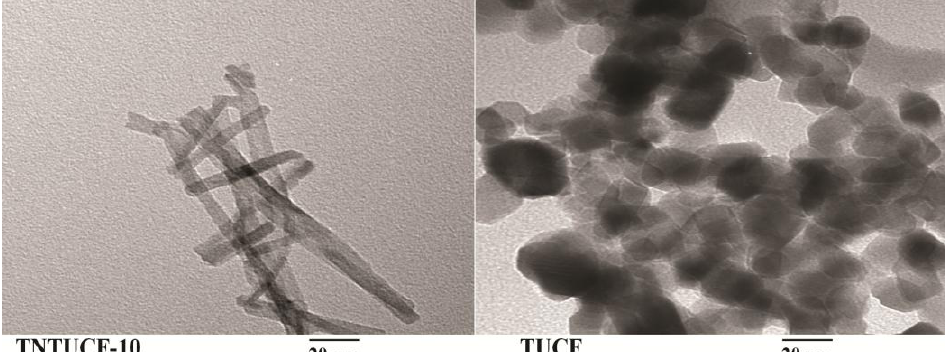
Figure 2. Transmission electron microscopy (TEM) of TNTUCF-10, and